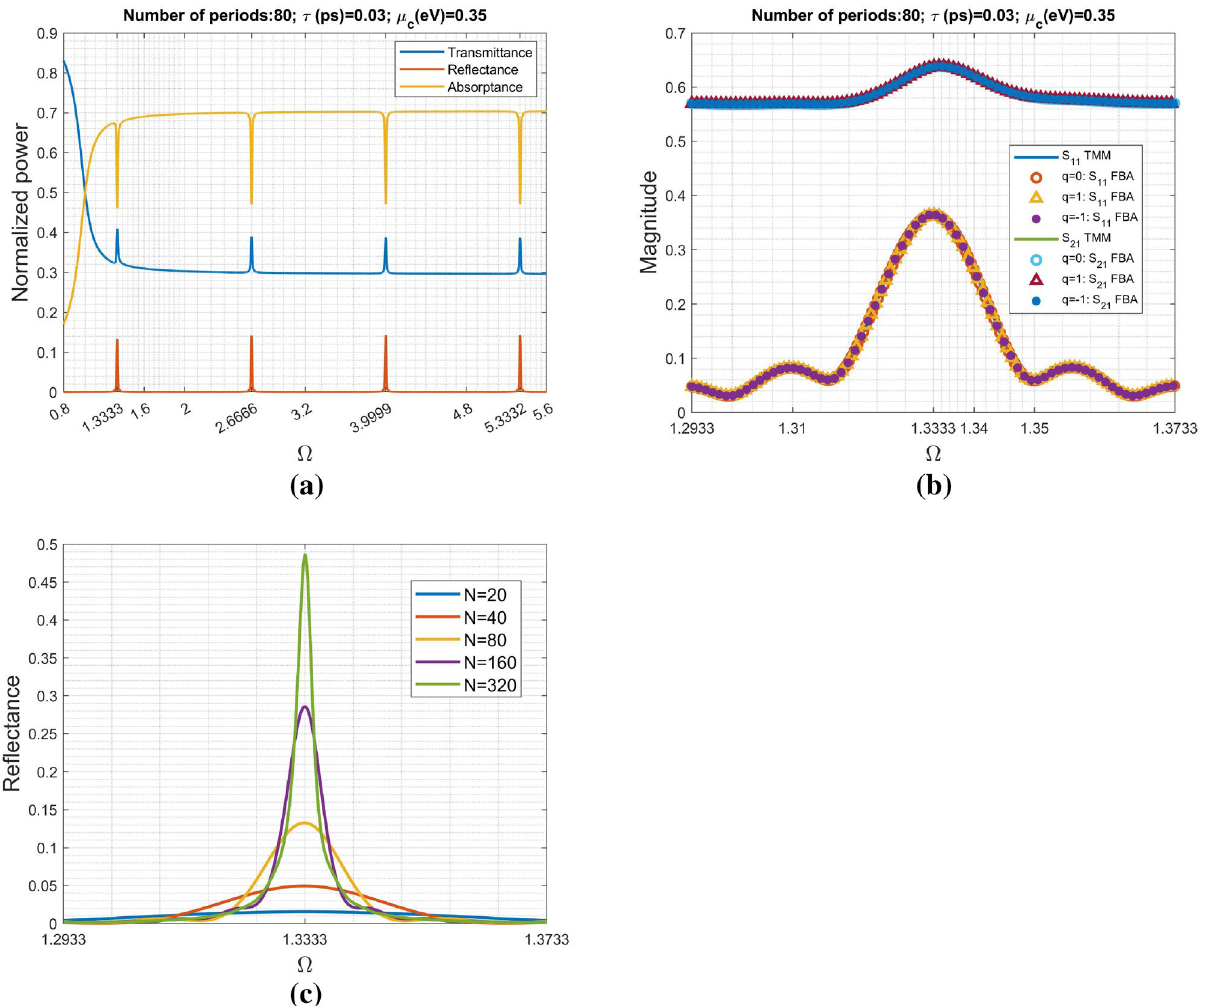
Figure 3. Scattering characteristics against normalized angular frequency ( (cid:31) ): ( a ) the power efficiency of transmittance, reflectance and absorptance (normalized to that of the incident power), and ( b ) scattering parameters against normalized frequency (around (cid:31) = 1.3333 ) obtained through the approaches including transfer matrix method and Floquet-Bloch theory. The number of unit cells (periods) is 80. The graphene sheet has the following parameters: µ c = 0.35 eV , T = 300° K, and τ = 0.03 ps . The dielectric slab is SiO 2 having refractive index n s = 1.5 and thickness of 442.8007 nm. The input and output regions both are SiO 2 to improve the impedance matching at interfaces. Figure ( c ) shows the reflectance response around the first peak in ( a ) for various N (number of